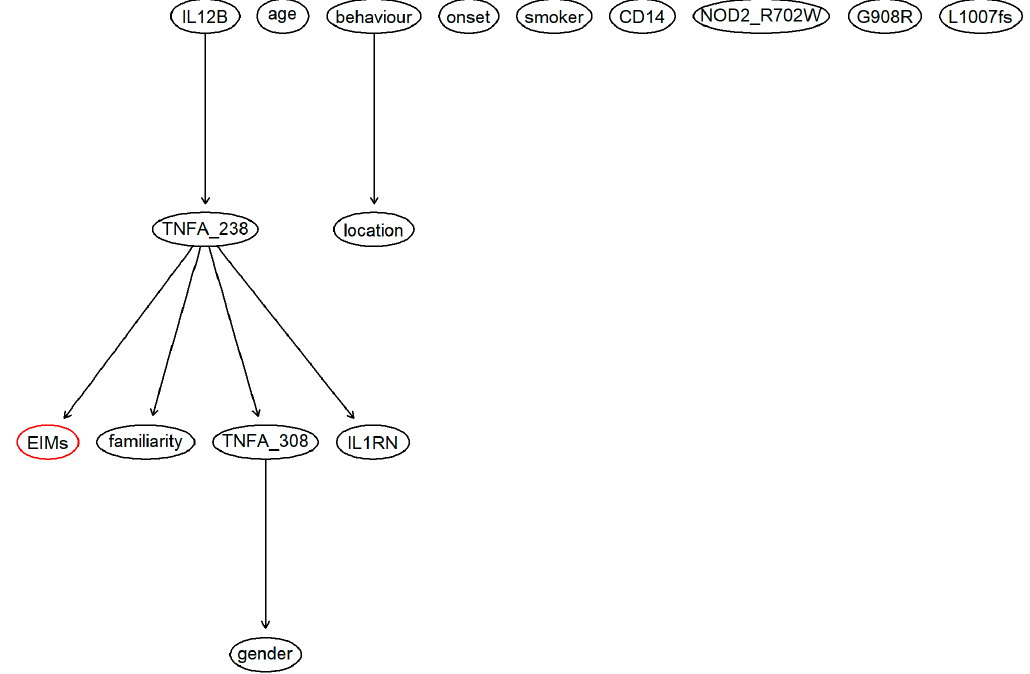
Figure 1. Structure of the Bayesian network estimated considering demographical variables, known risk factors and genetic factors. The red node is the clinical endpoint, which indicates the presence or absence of EIMs. The chosen network was learned with the Tabu Search algorithm, which is one of the available algorithms in the “bnlearn” R package.